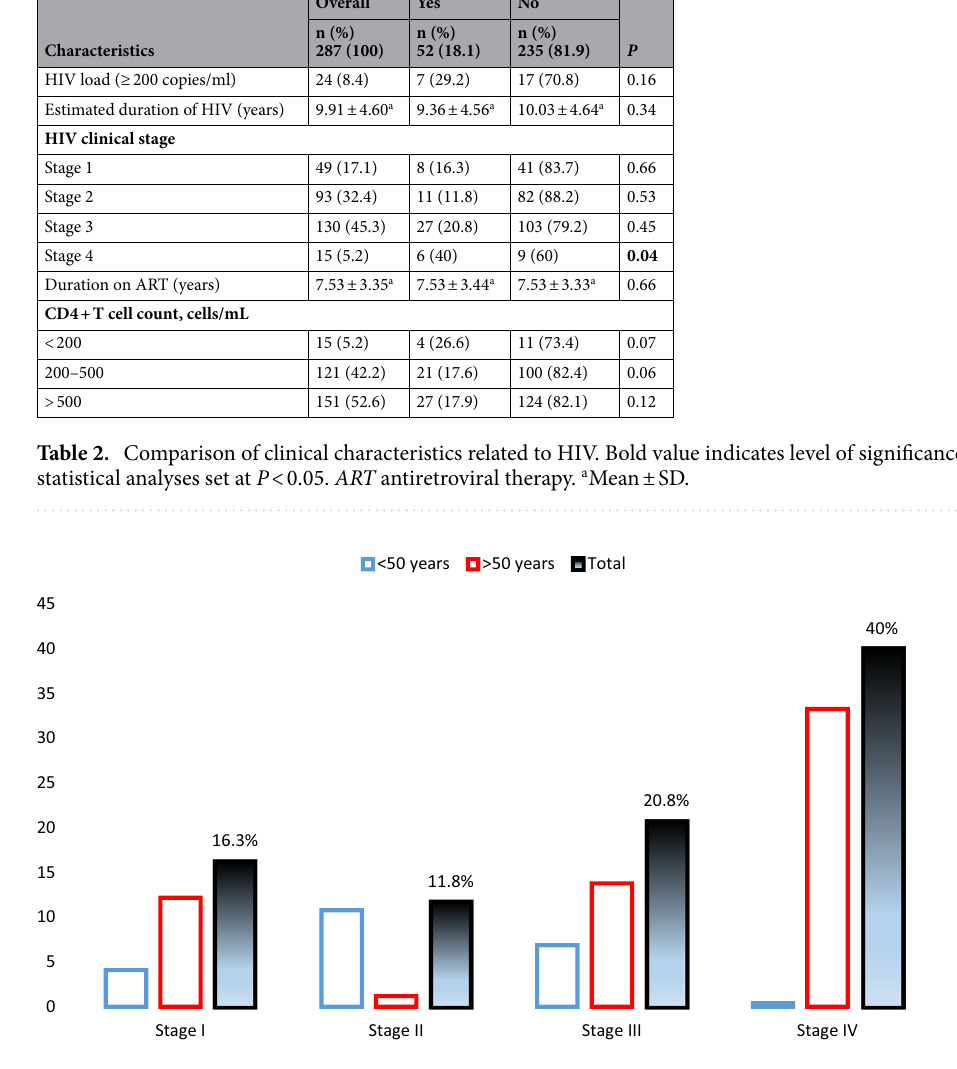
Figure 2. Lower extremity arterial disease prevalence according to the HIV clinical stages (I, II, III, IV).